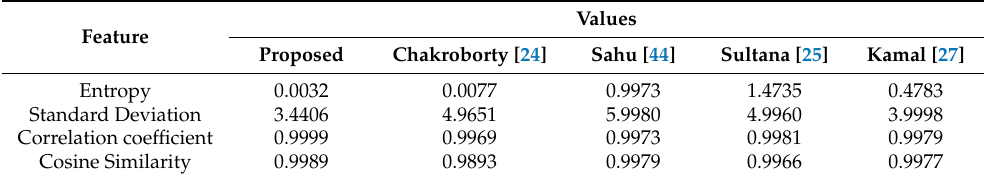
Table 3. Aggregated values of statistical features of various